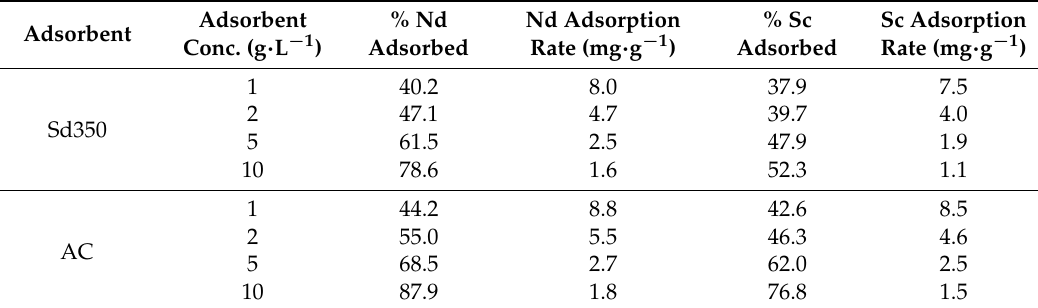
Table 3. % Sc and Nd adsorption (initial concentration 20 mg · L − 1 ) on biochar Sd350 and AC